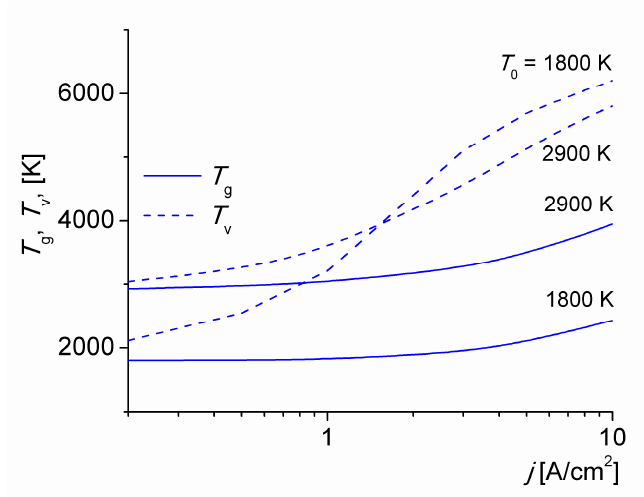
Figure 1. Gas and vibrational temperatures versus the discharge current density for various T 0 .